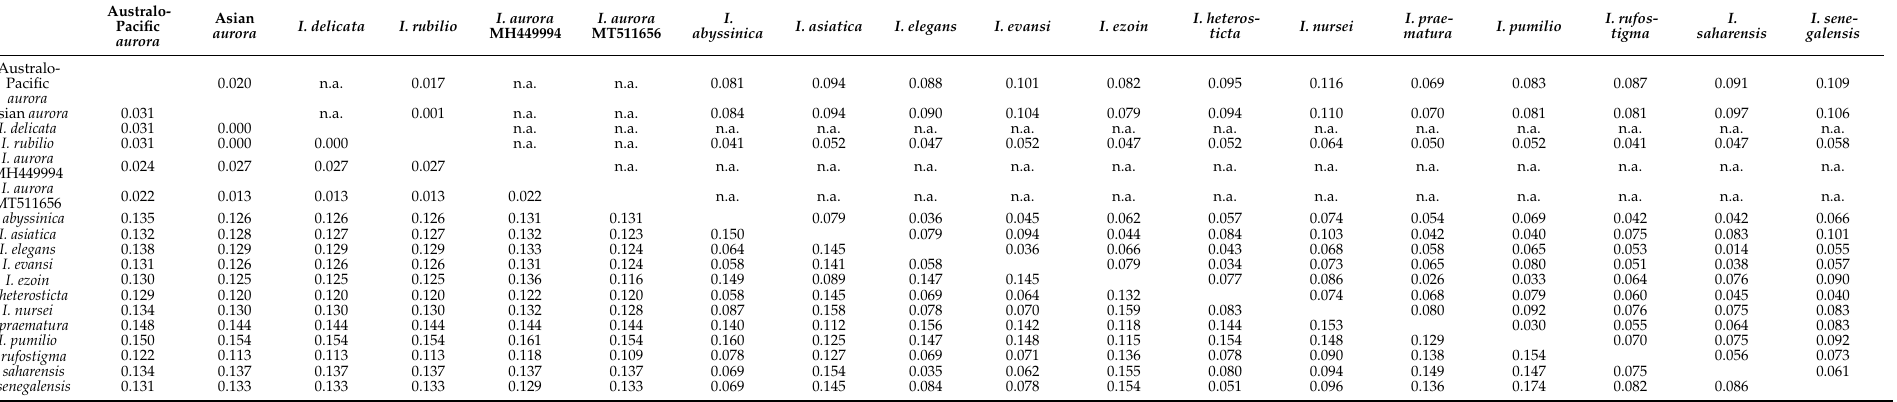
Table A3. Evolutionary divergence (uncorrected p-distances) estimated with MEGA X from nuclear ( ITS , above) and mitochondrial ( COI , below) DNA sequence